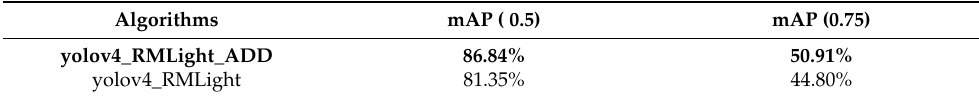
Table 3. Data augmentation experiment results.